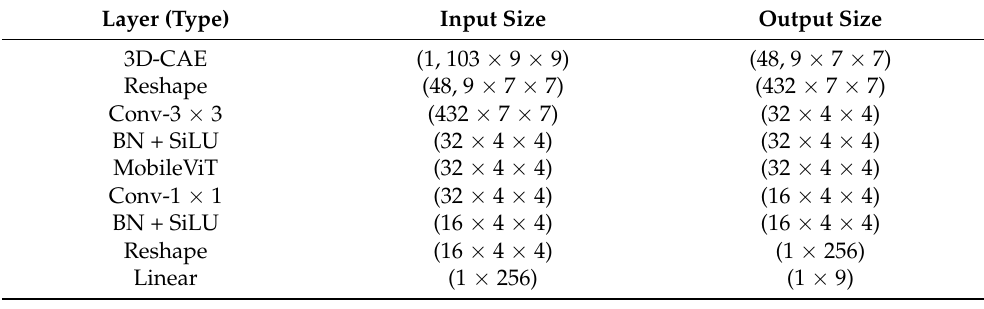
Table 5. Parameter settings of the CAEVT network when applied to the Pavia University